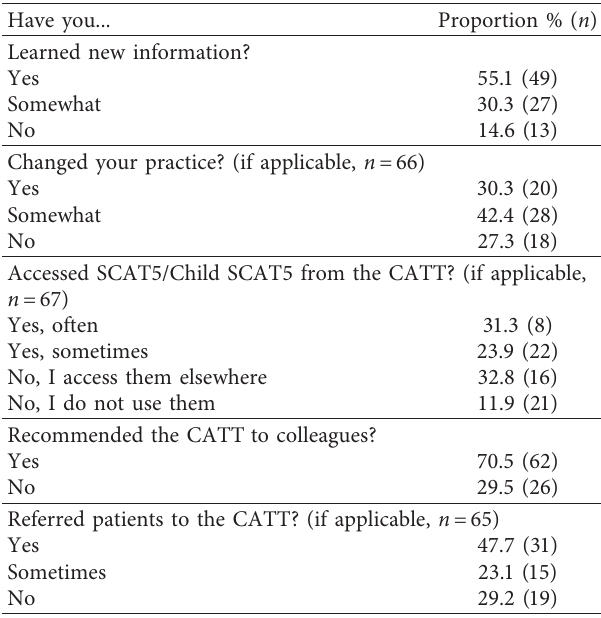
Table 4: QA/QI self-reported learning and behavior following completion of the redeveloped CATT for medical professionals ( n � 89).